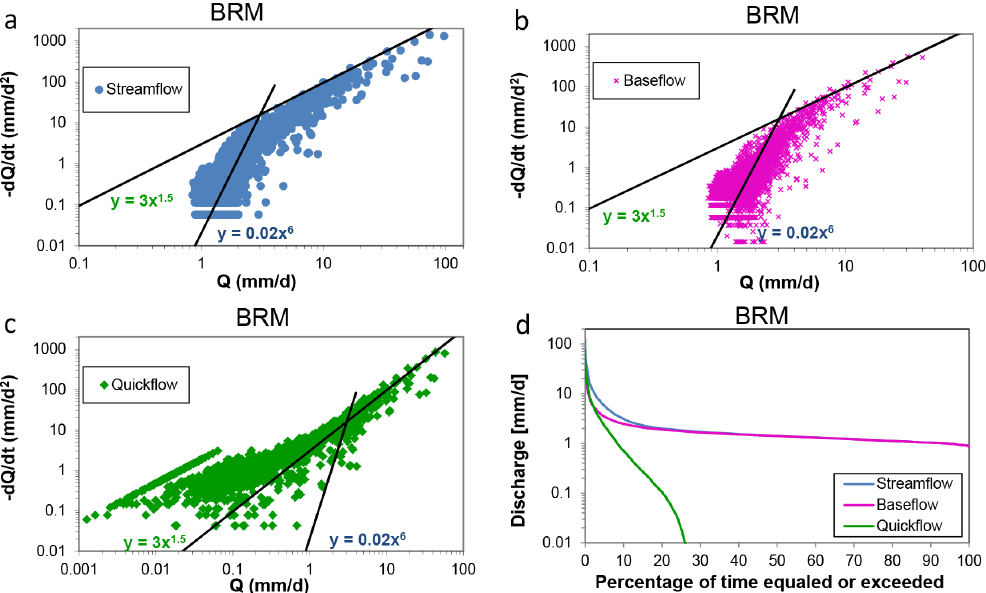
Figure 5. (a–c) Recession plots showing streamflow, baseflow and quickflow from the 1996 GH1 hourly flow record. The line through the mid-flow streamflow and baseflow points has slope of 6.0, and that through the higher flow quickflow points (flows greater than 1mmday − 1 ) has slope of 1.5; (d) flow duration curve showing streamflow, baseflow and